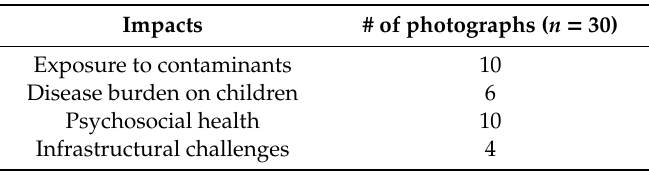
Table 4. Thematic summary of